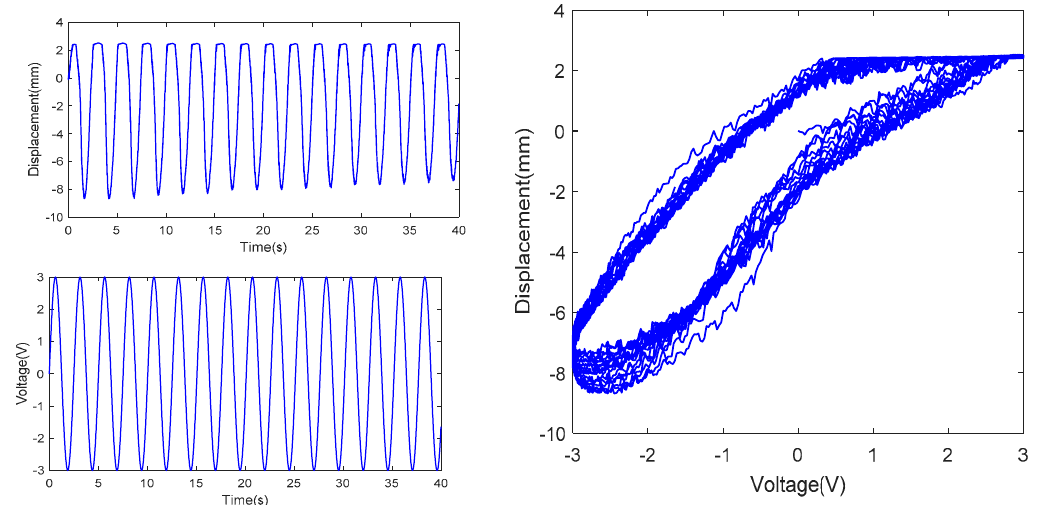
Figure 11. Tip displacement at actuating voltage with amplitude of 3V and frequency of 1/2 π Hz.